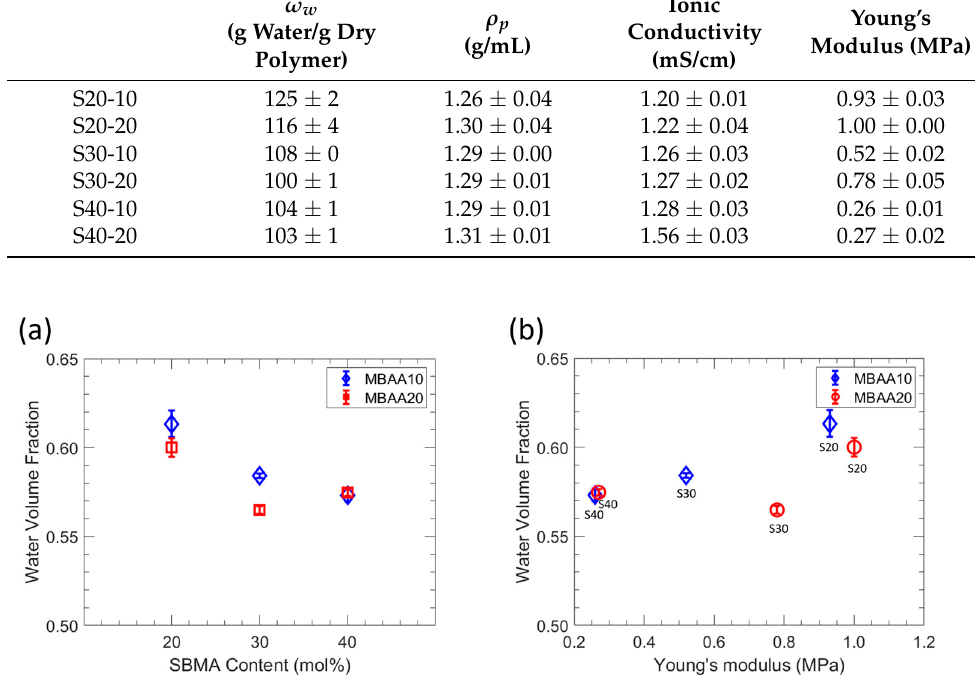
Figure 3. ( a ) Water volume fraction as functions of SBMA content. ( b ) Water volume fraction as function of Young’s modulus. Table 2. Water uptake, dry polymer density, and ionic conductivity of all films.